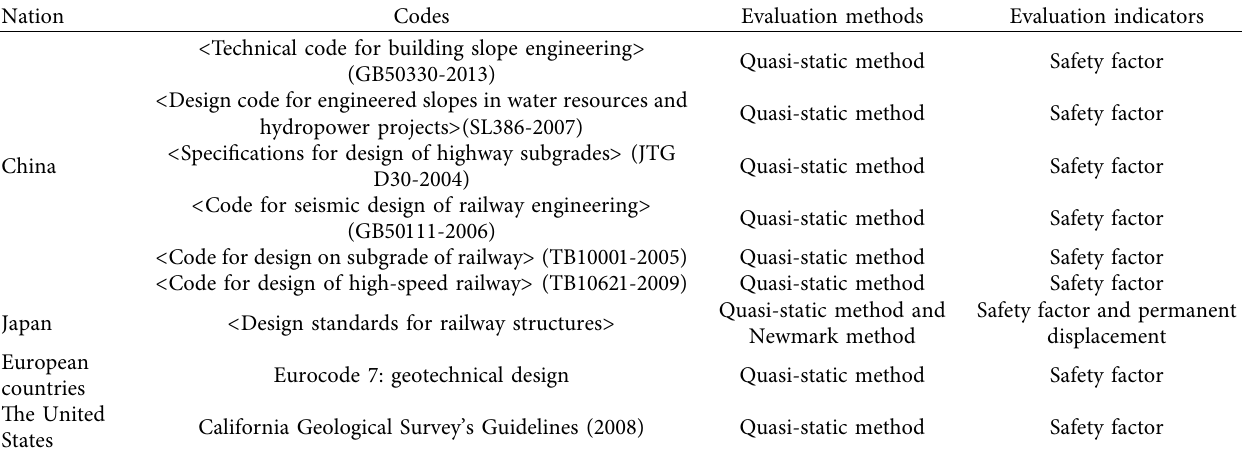
Table 1: Slope codes of the earthquake-prone countries.